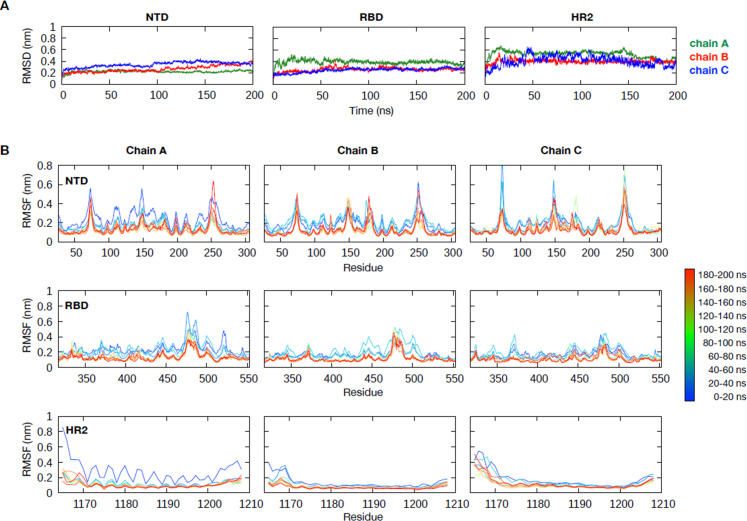
Structural stability of full-length spike (S) protein model from all-atom simulations.(A) Root mean square deviation of the C⍺ atoms of the N-terminal domain (residues 27–305), receptor binding domain (RBD) (residues 317–553), and heptad repeat 2 domain (residues 1165–1208) for all three chains of the S protein throughout the 200 ns simulation. (B) Root mean square fluctuation (RMSF) of these three domains calculated for every 20 ns window throughout the simulations. ACE2: angiotensin-converting enzyme 2.